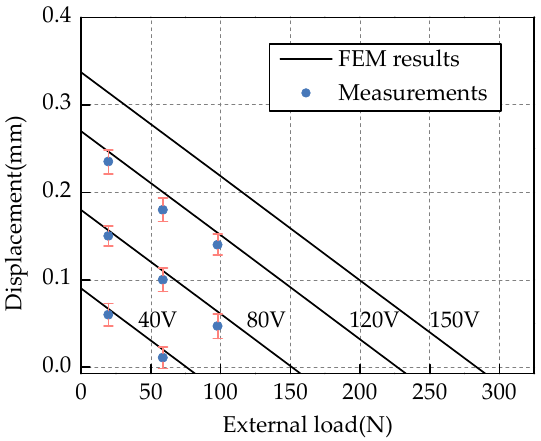
Figure 11. Output strokes under external loads.